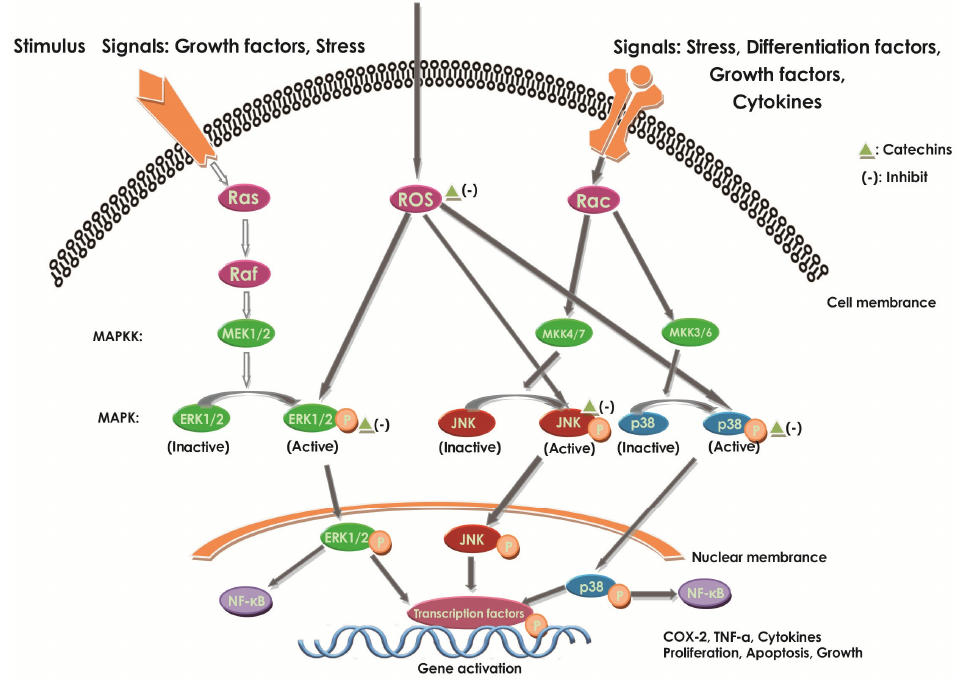
Figure 6. Catechins show an inhibition of the MAPK cascade pathway through the inhibition of the phosphorylation of ERK1/2, JNK, and